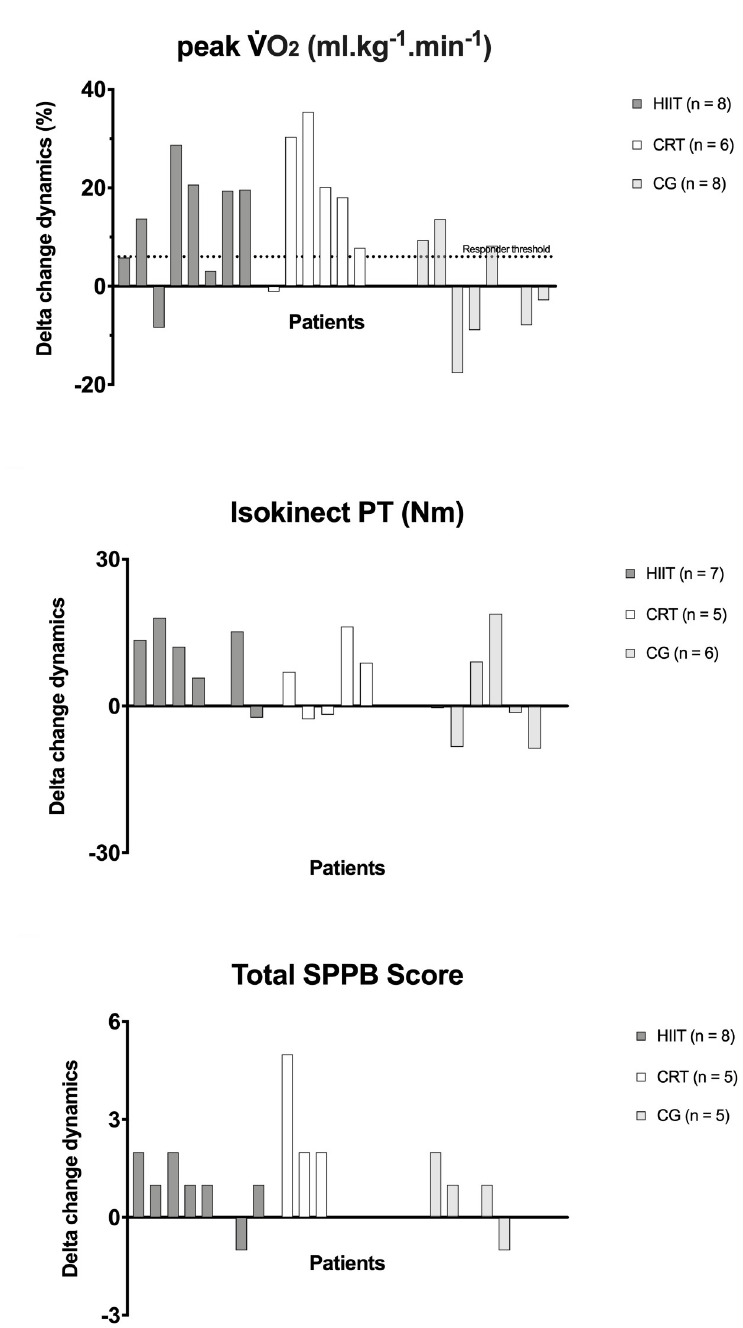
Fig 6. Delta change variation. Responder threshold for _ V _ O 2 (minimum 6% increase mL/kg/min). HIIT, high- intensity interval training; CRT, circuit-resistance training; CG, control group; _ V _ O 2 , oxygen uptake; mL/kg/min, millimeter per kilogram per minute; W, watt; SPPB, short physic performance battery.